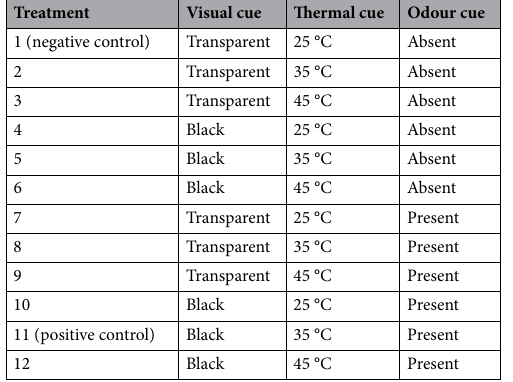
Table 2. Summary of the twelve tested treatments which resulted from all possible combinations of the three studied host-associated